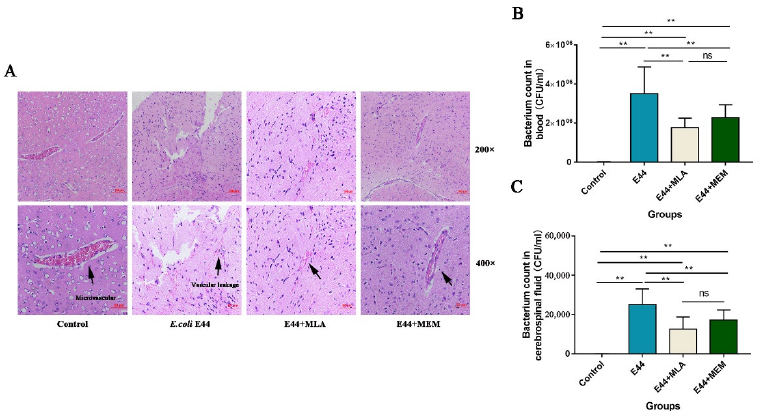
Figure 6. Protective effects of MLA and MEM attenuating BBB lesions and inflammation in E. coli - induced mice in vivo. ( A ) Morphological observations of brain microvascular in wild-type mice pretreated with MLA and MEM by H&E staining. ( B ) Bacteria counts in blood and cerebrospinal fluid of mice infected with E. coli E44 detected by the dilution method of plate counting. ( C ) Bacteria counts in cerebrospinal fluid of mice infected with E. coli E44 in different pretreat groups. ** p < 0.01; NS, no significance. Thirty-two mice were randomly divided into four groups (control group, E44 group, MEM group, and MLA group). Mice in each group were given a normal saline solution containing MLA (5 mg/kg) or MEM (20 mg/kg) by intraperitoneal administration for 3 days. After E. coli E44 infection for 8–10 h, mouse brains were collected for morphological observation. H&E staining showed that E. coli E44 could induce impairments in endothe- lial cells and cause brain microvascular damage. Histological damage was characterized by microvascular collapse, the destruction of the bases, and RBC cells that were irregularly positioned into the tissue space. Few well-structured blood capillaries could be observed under a typical view (Figure 6A). Under a 400× amplification microscope, MEM-pre- treated mice and MLA-pretreated mice exhibited relatively protective effects on E. coli - induced BBB injuries, as characterized by the more well-structured brain capillaries and morphological integrity of HBMECs. In addition, both MEM and MLA showed good im- provements in E. coli -induced BSM, as determined by bacterial counts in blood and cere- brospinal fluid ( p < 0.01) (Figure 6B,C). These results consistently suggested that MLA and MEM could attenuate E. coli -induced BBB injuries in vitro and in vivo. 3.5. α7nAChR/CISH/JAK2/STAT5 Axis is Critical for E. coli-Induced BBB Disruptions In this study, we found that E. coli E44 infection could trigger the α7nA- ChR/JAK2/STAT5 signaling pathway in HBMECs. Nicotine (α7nAChR agonist) aggra- vated E. coli -induced BBB injuries, while MLA and MEM (α7nAChR antagonist) exhibited protective effects by regulating the α7nAChR/CISH/JAK2/STAT5 signaling pathways during infection. CISH was proven to function as a negative executor, which inhibits the activation of p-JAK2 and p-STAT5b in infective HBMECs (Figure 7).